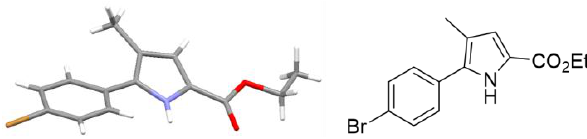
Figure 1. Crystal structure of pyrrole 10 (CCDC 1562557) [8].